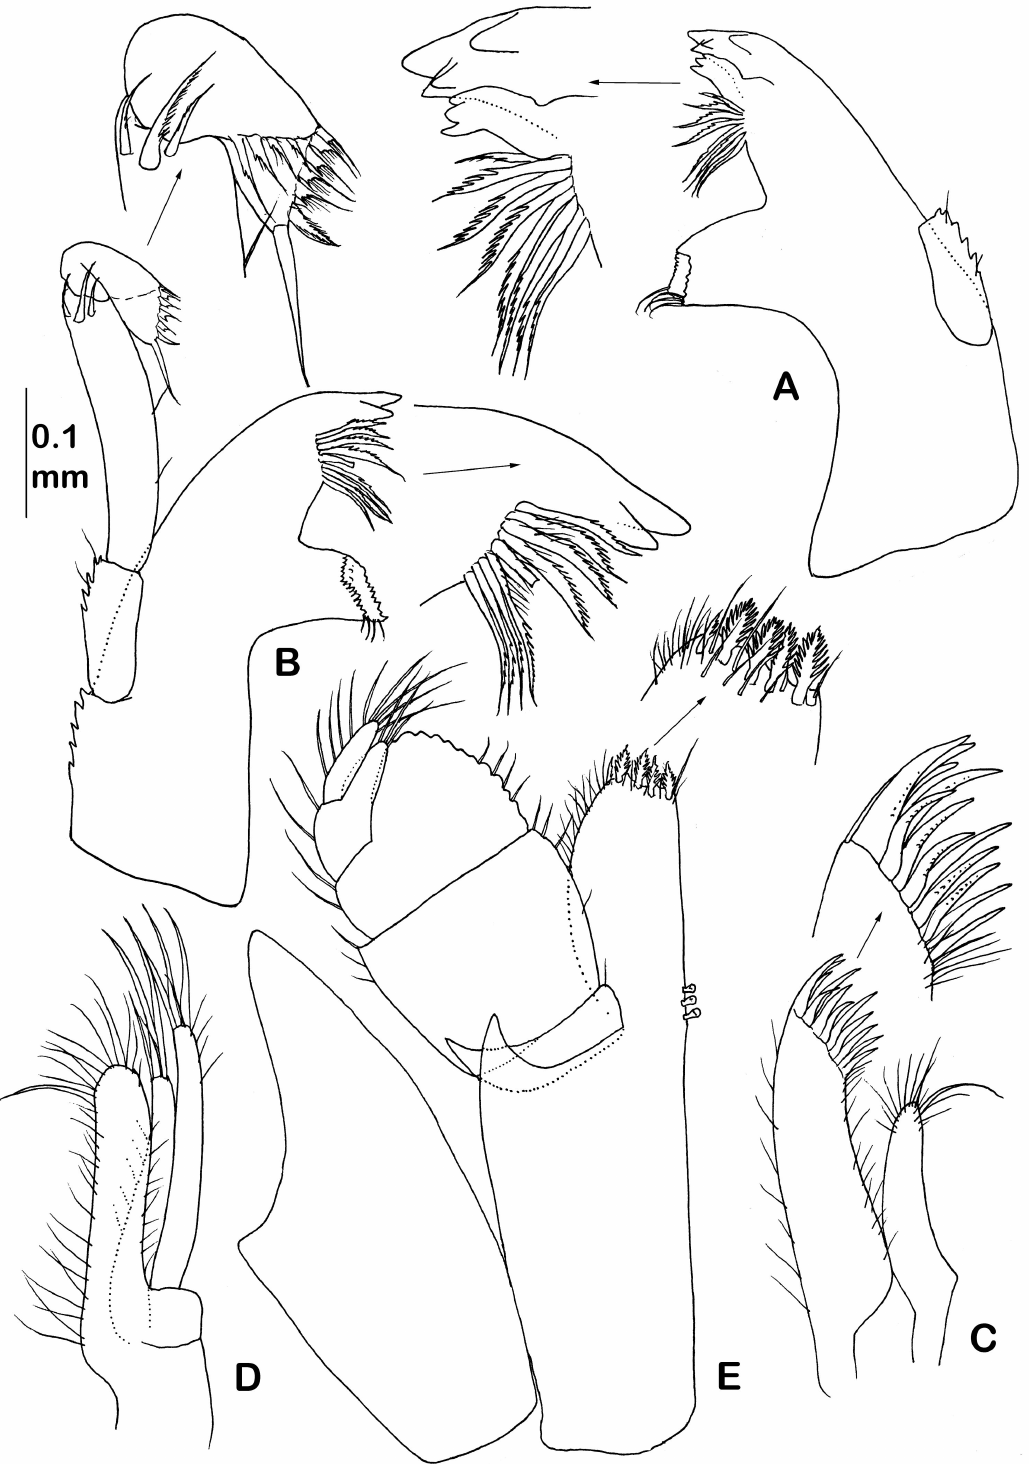
Figure 34. Eurycope jakobi sp. nov. Female paratype (ZMH K-45658): ( A ) left mandible, ( B ) right mandible; ( C ) maxilla I; ( D ) maxilla II; ( E ) maxilliped (all mouth parts with enlarged distal